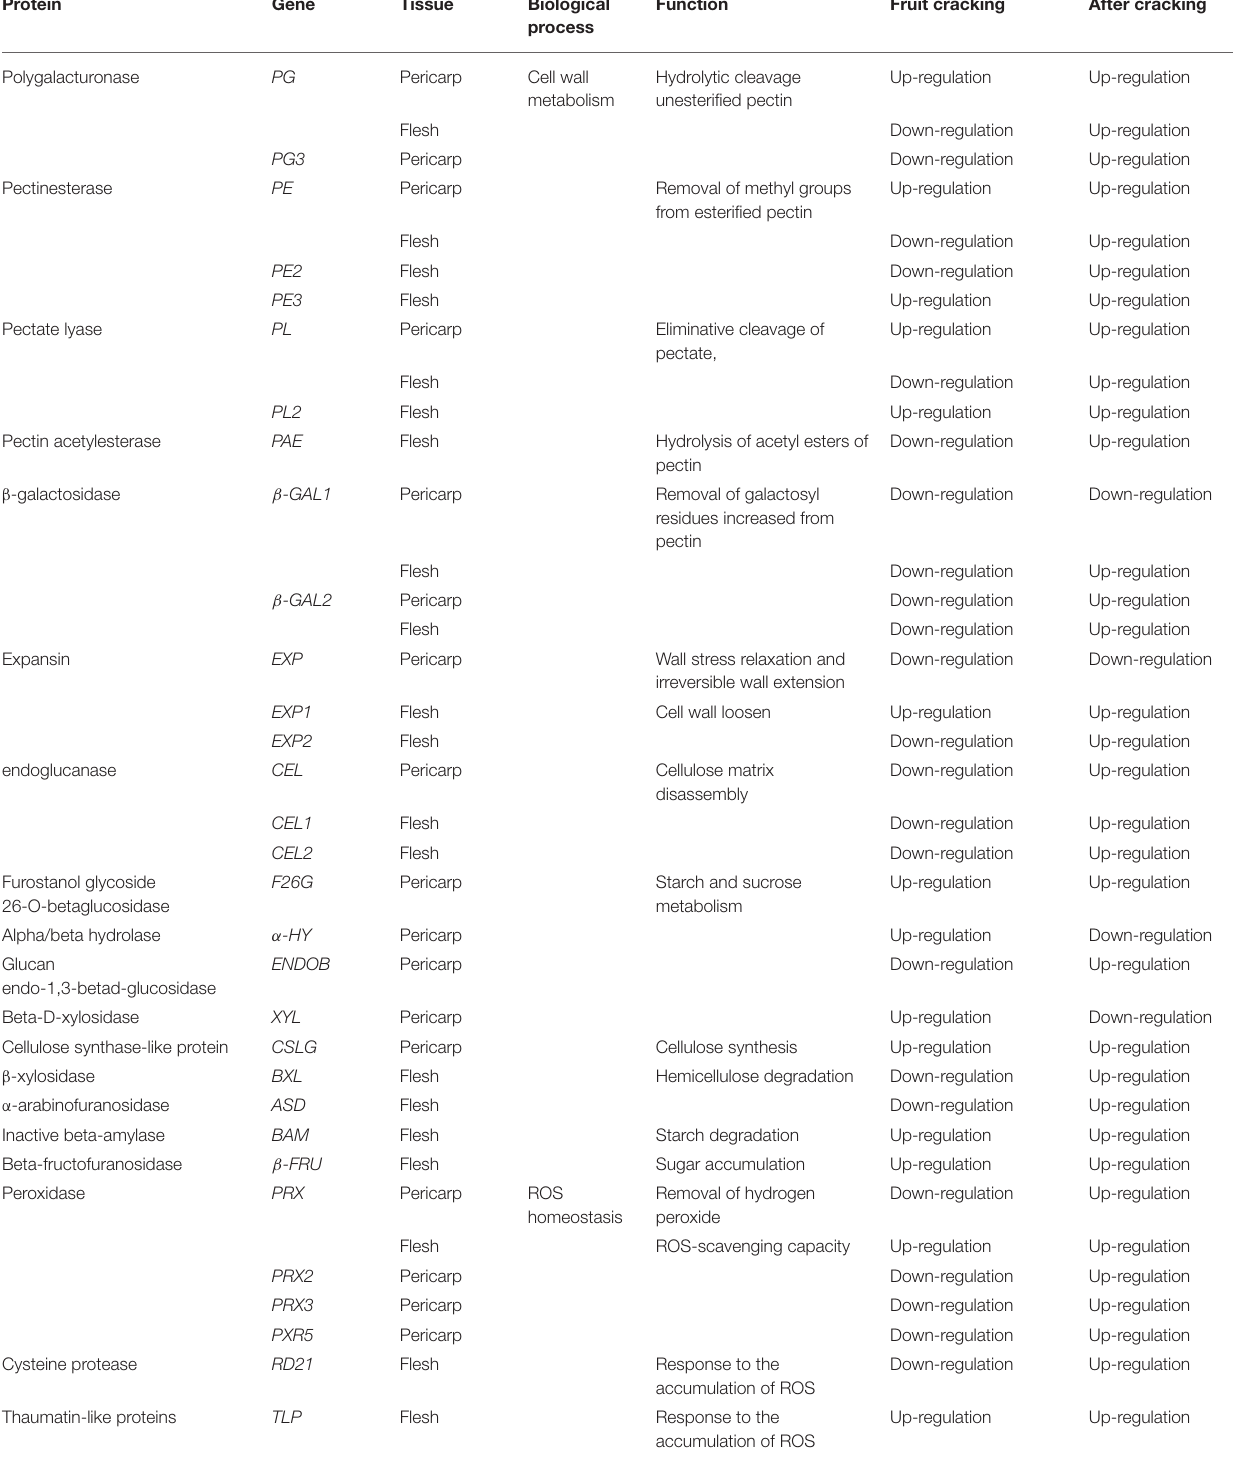
TABLE 5 | Different expressional gene and different abundant protein during fruit cracking and soften in A. trifoliata *